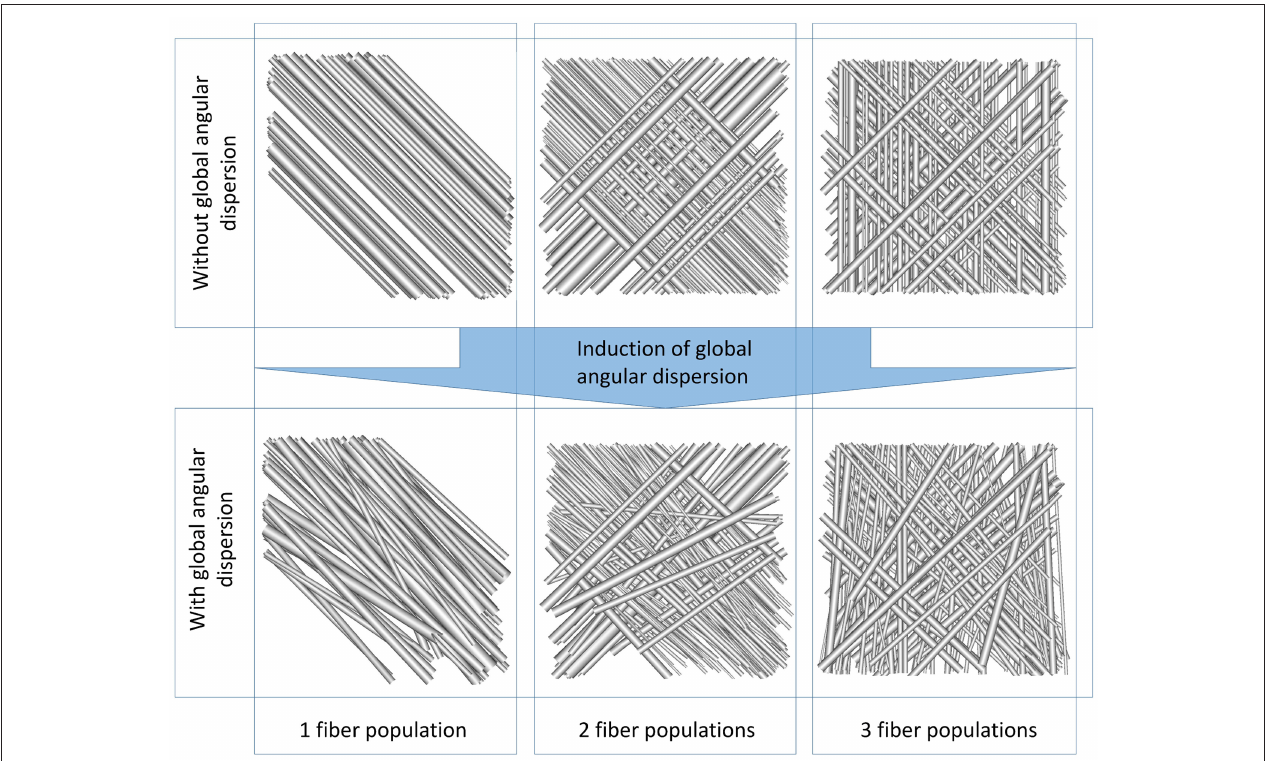
FIGURE 5 | (Top) Surface renderings of outer fiber envelopes corresponding to one (left), two (middle), and three (right) fiber populations with intracellular fraction of 0.06 for one population, 0.03 each for the two populations, 0.02 each for the three populations and mean diameters 2.5 µ m (one population), 1.5 and 2.5 µ m (two populations), 1.5, 2.0, and 2.5 µ m (three populations). Bottom same as top. with global angular dispersion of 10 ◦ for the single population, 5.5 and 8.5 ◦ for the two populations, 5.5, 6.7, and 8.5 ◦ for the three populations (for a target angular dispersion of 10 ◦